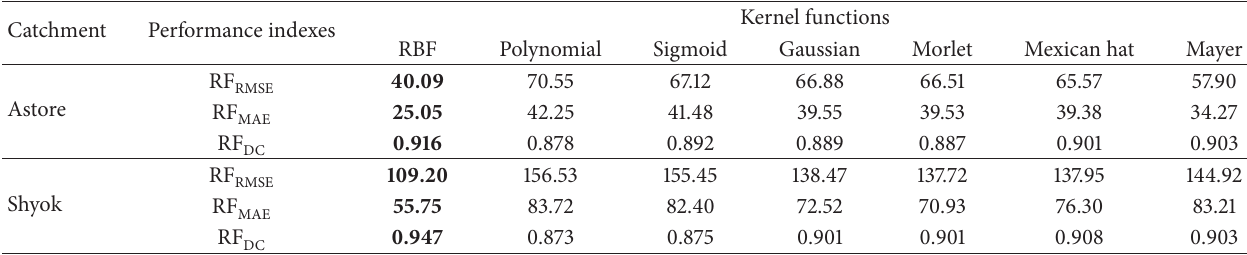
Table 4: Comparison of HLGSA performance for different kernel functions using best data set of Astore and Shyok catchments.